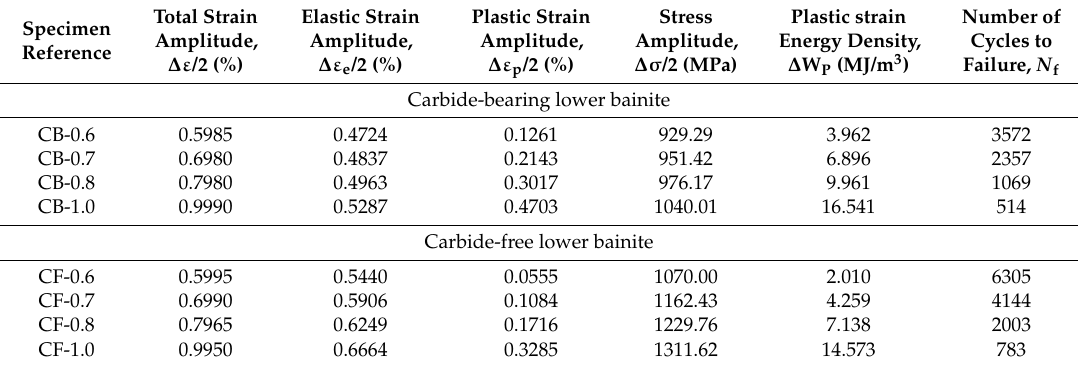
Table 1. Low-cycle fatigue test